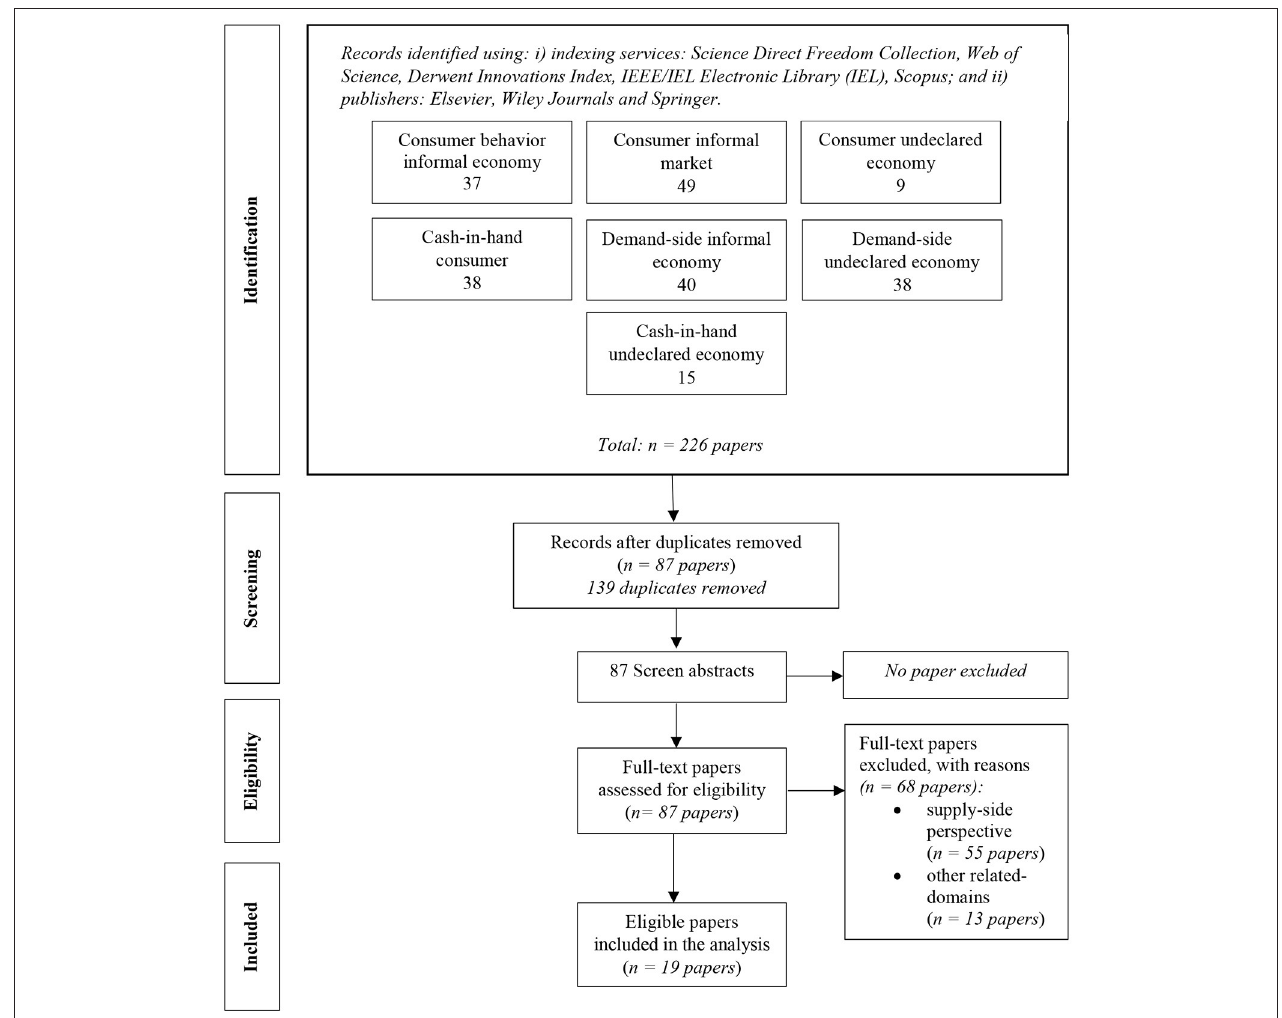
FIGURE 1 | PRISMA flow diagram describing the search results, the screening and study